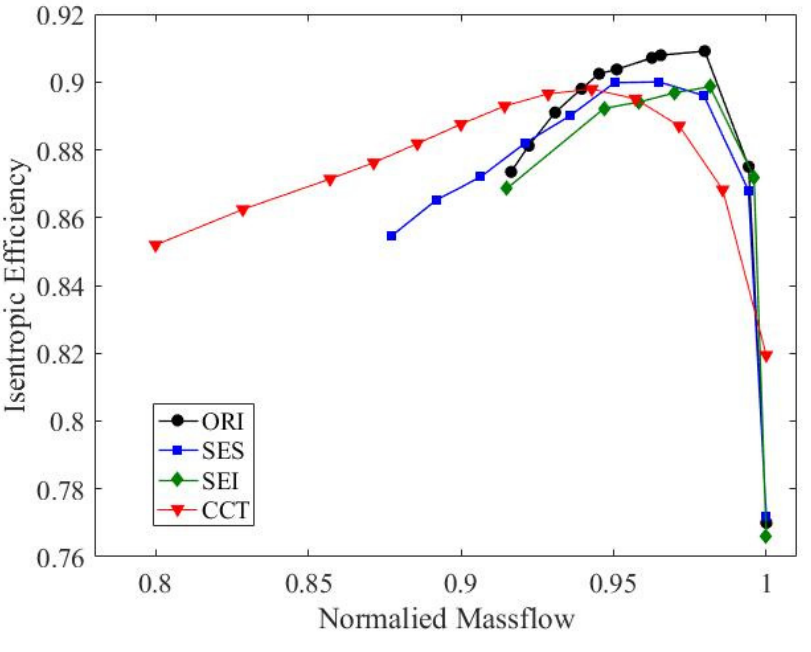
Figure 5. Comparison of performance curves.